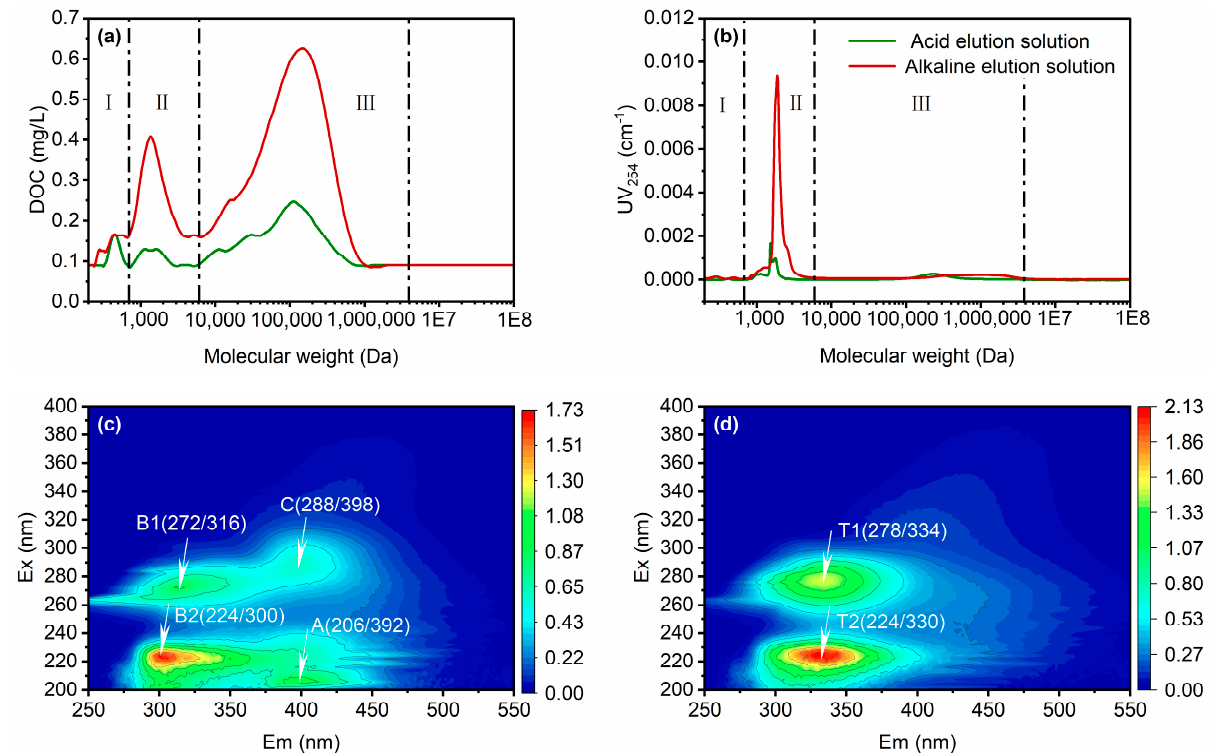
Figure 6. Plots of molecular weight (MW) distribution and EEM spectra of NF membrane cleaning solutions: MW distributions of ( a ) DOC and ( b ) UV responses for the acid and alkaline cleaning solutions; and EEM spectra of ( c ) acid cleaning solution and ( d ) alkaline cleaning solution. The membrane cleaning was performed after 408-hr operation at flux of 20 L/(m 2 ·h).